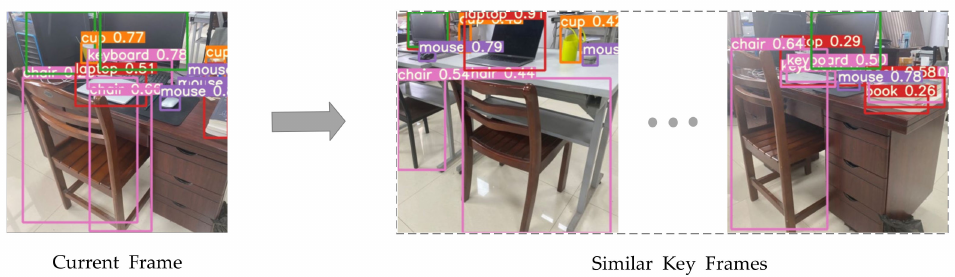
Figure 8. Object detection for the current frame and finding similar key frames by the binary classified